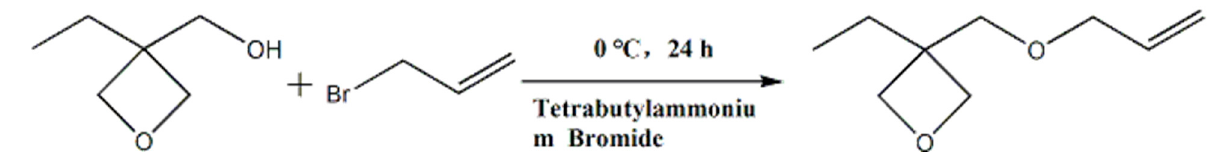
Figure 2. The synthetic route of 3-ethyl-3-allylmethoxyoxetane.